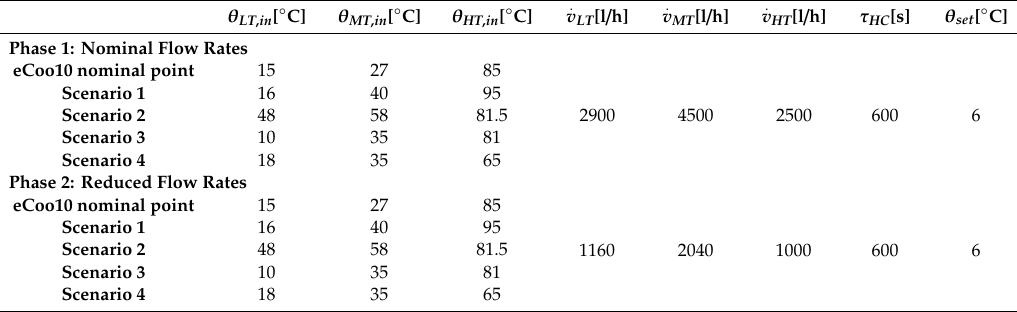
Table 5. Summary of the boundary conditions of the experimental